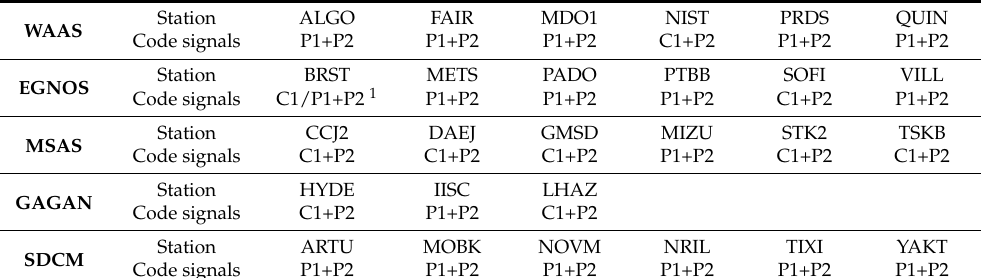
Figure 13. The distribution of the selected IGS stations. Table 3. The code signals used at each selected IGS station.